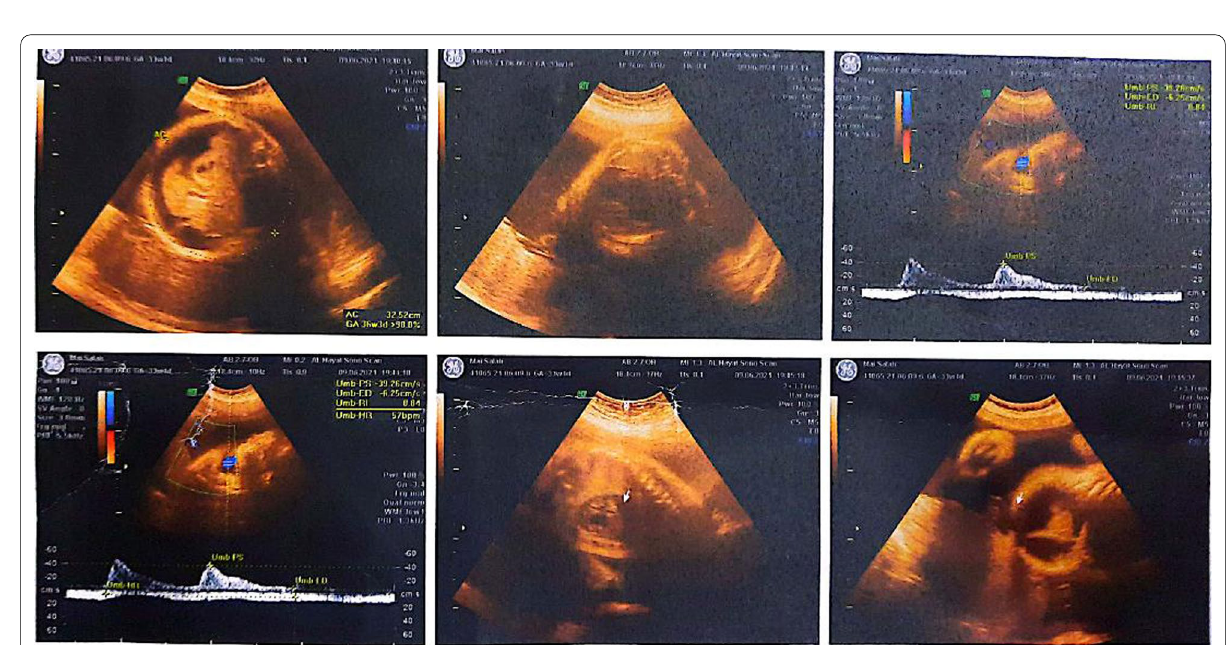
Fig. 2 4D obstetric ultrasonography in the 34th gestational